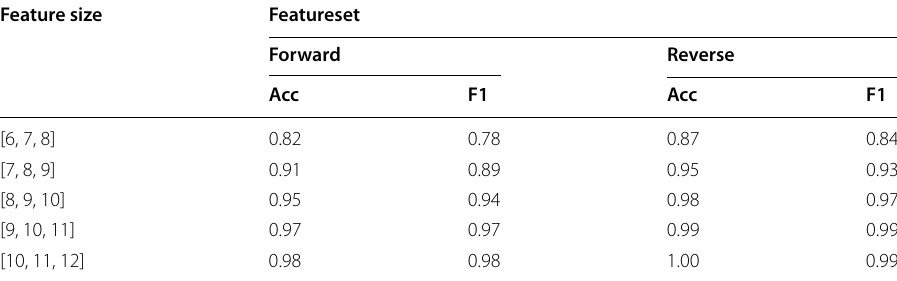
The k‑mer size is set to 3. Accuracy indicated by Acc and F1‑Score indicated by F1